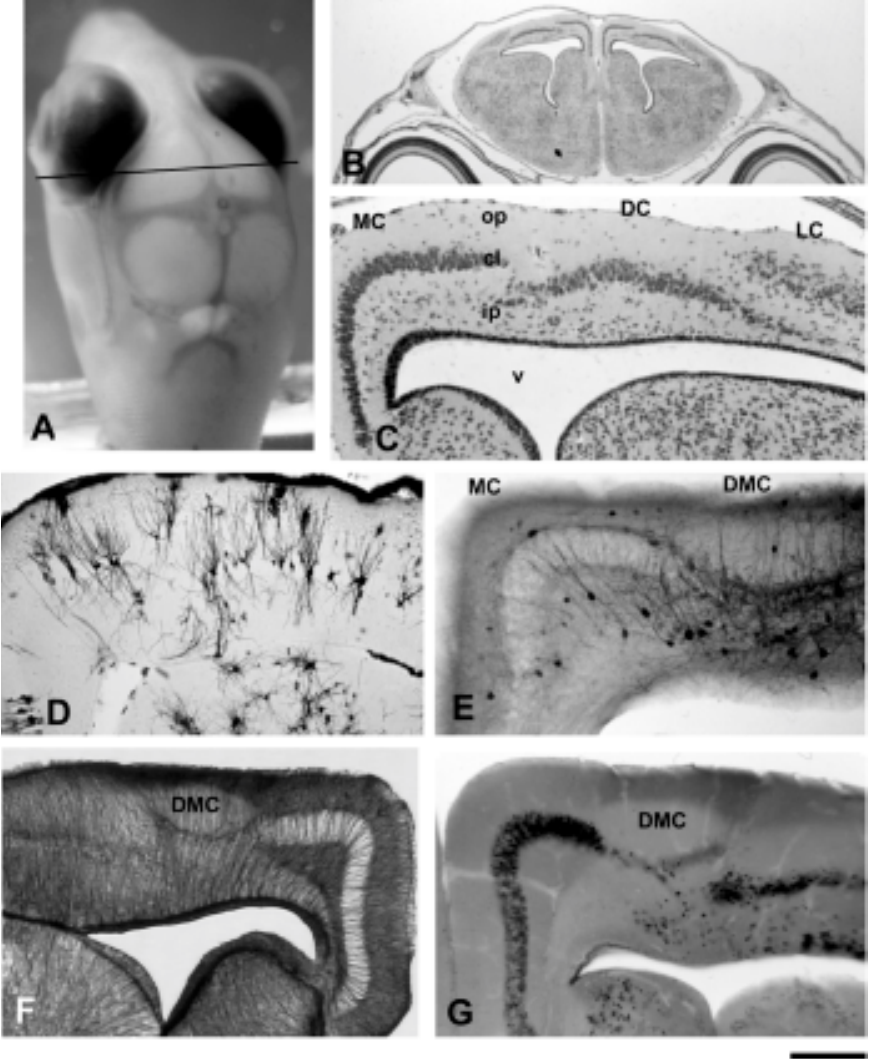
Fig. 1 – The lizard cerebral cortex. A: Dorsal view of the head of a lizard embryo showing the two telencephalic vesicles between the two pigmented eyeballs and the two posterior mesencephalic vesicles (optic tecta). B: Transversal section to the telencephalon of the lizard embryo in the plane signalled by the line inA. C: Idem, enlarged aspect of the right hemisphere; observe most neuronal somata grouped in conspicuous cell layer ( cl ) sandwiched between the inner ( ip ) and the outer ( op ) plexiform layers. D: Golgi impregnated transversal section showing the bitufted aspect of the lizard cortex principal neurones. E: Parvalbumin immunostained section showing positive interneurons in the plexiform layers and a dense plexus of immunopositive axons surrounding the cell layer of the dorsomedial cortex. F: Glial fibrillar acidic protein immunostaining in the lizard cerebral cortex; observe the scaffold of radial ependymal processes which delineate most lizard cortex subregions. G: Transversal section of the lizard cortex immunostained for C-Fos showing positive nuclei in most principal neuronal somata of the principal cell layers (i.e., they are very active) nevertheless, those of the dorsomedial cortex appear negative (i.e., likely due to the intensive parvalbumin-GABA perisomatic inhibitory input as seen in E). ( DC – dorsal cortex; DMC – dorsomedial cortex; LC – lateral cortex; MC – medial cortex) (Scale bar represents 1 mm in A, 500 µ m in B, 200 µ m in C and 150 µ m in D, E, F and G).